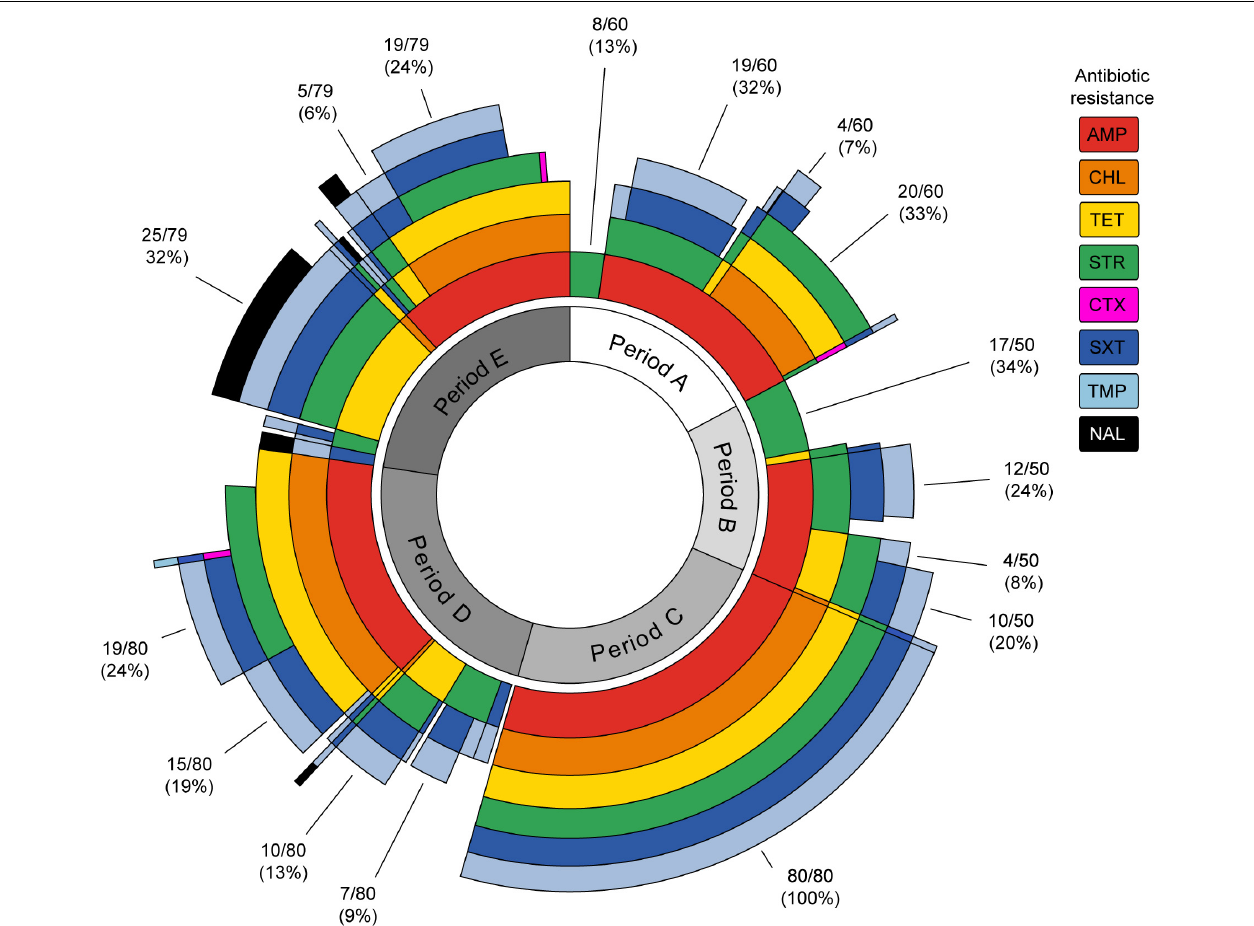
FIGURE 2 | Sunburst plot showing the antibiotic resistance and multi-drug resistance phenotypes of Shigella sonnei strains isolated in different time periods. Each antibiotic is represented by a concentric circle of a different color. The sum of the concentric circle represents the resistance phenotype pattern for each strain. The percentages of most frequent profiles for each period are shown. AMP, ampicillin; CHL, chloramphenicol; TET, tetracycline; STR, streptomycin; CTX, cefotaxime; SXT, sulfamethoxazole/trimethoprim; TMP, trimethoprim; NAL, nalidixic acid. The figure was prepared using the sunburstR (Bostock et al., 2019) package in R (R Core Team,